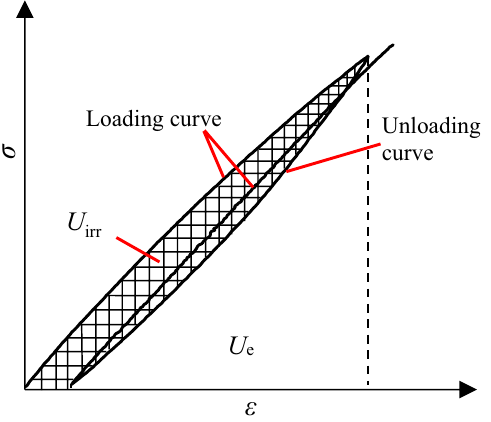
Figure 8. Relationship between elastic strain energy ( U e ) and dissipated energy ( U irr ) of rock mass